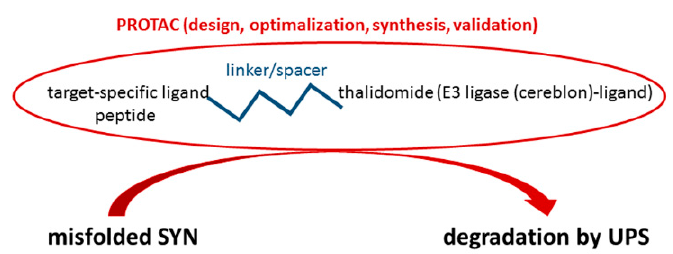
Figure 5. The PROteolysis TArgeting Chimera (PROTAC) Figure 5. T he PROteolysis TArgeting Chimera (PROTAC) technology. Figure 5. T he PROteolysis TArgeting Chimera (PROTAC) technology.